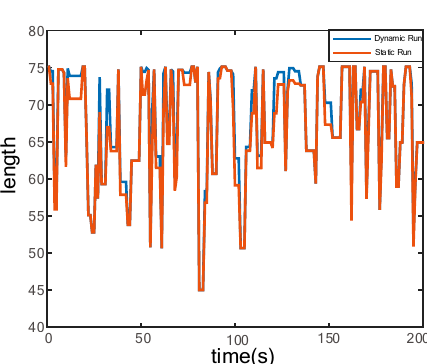
Figure 7. Non-cleaned cells.